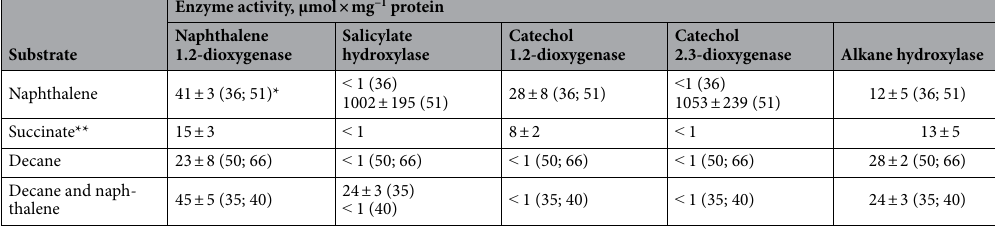
Table 3. Activity of the key enzymes of naphthalene and decane degradation. *Time, h. **Enzyme activity was measured in the biomass of cells sampled at the end of the exponential growth phase.